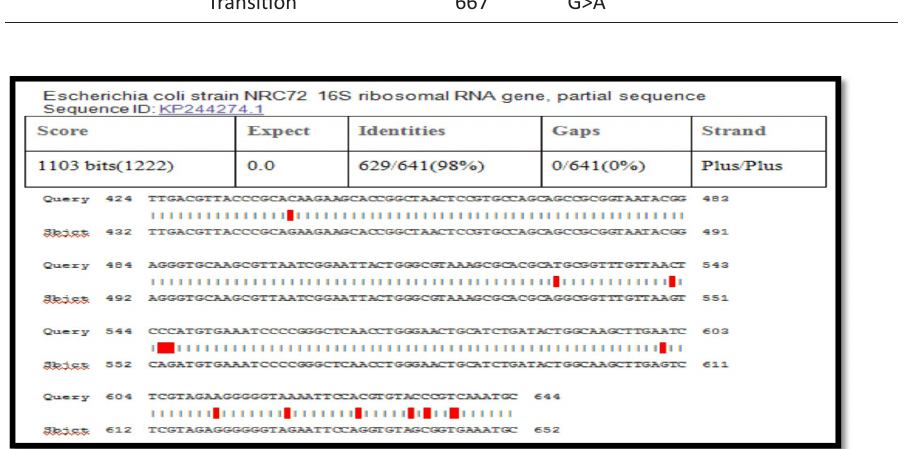
Fig. 6. Sequence analysis of 16S rRNA gene for E.coli isolate